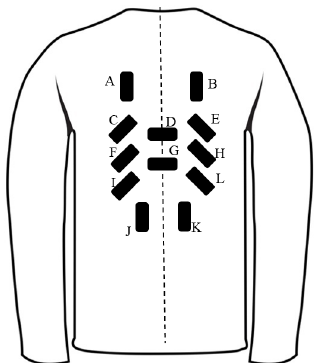
Figure 5. The identified positions of the BWSs as determined by the stretchable shirt. A, B, J, and K were included specifically for flexion/extension. Lateral bending was detected by C, F, I, E, H, and L. D D and G were specified for axial rotations. and G were specified for axial